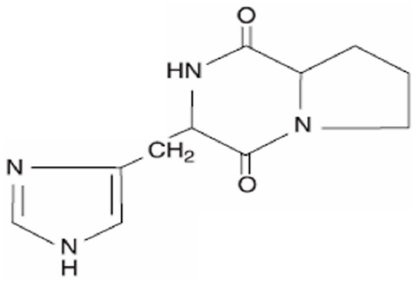
Figure 1. Cyclo(His-Pro) chemical structure.